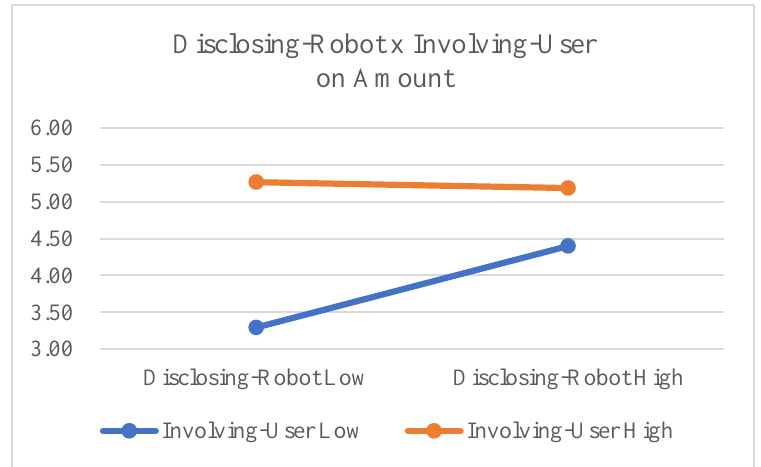
Figure 9. Interaction effects on amount.